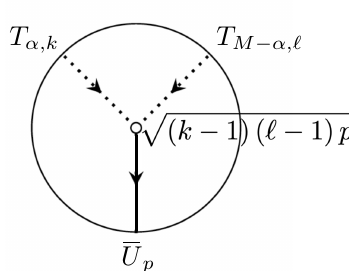
Figure 4 . The cubic effective Witten-like diagram describing the interaction of two chiral twisted operators belonging to conjugate twisted sectors and one anti-chiral untwisted operator. The cubic vertex is p ( k − 1) ( ‘ − 1) p times δ enforcing charge conservation. As in the previous figures, k + ‘ − p, 0 this δ -function is understood.